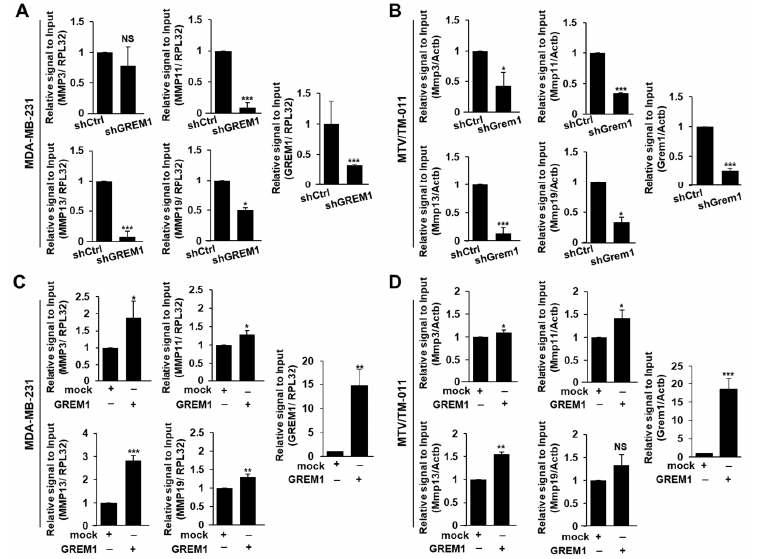
Figure 5. GREM1 regulates the expression of MMPs in breast cancer cells. ( A , B ) Relative mRNA levels of MMPs in GREM1 -depleted breast cancer cells. ( C , D ) Relative mRNA levels of MMPs in GREM1 -overexpressing breast cancer cells. MDA-MB-231 and MTV / TM-011 cells were transfected with each indicated plasmid for 48 h, and mRNA levels of genes were quantitated by qPCR analysis. Data are presented as the mean ± SD of three independent experiments. Two-sided t -test. *, p < 0.05; **, p < 0.01; ***, p < 0.001; NS, not